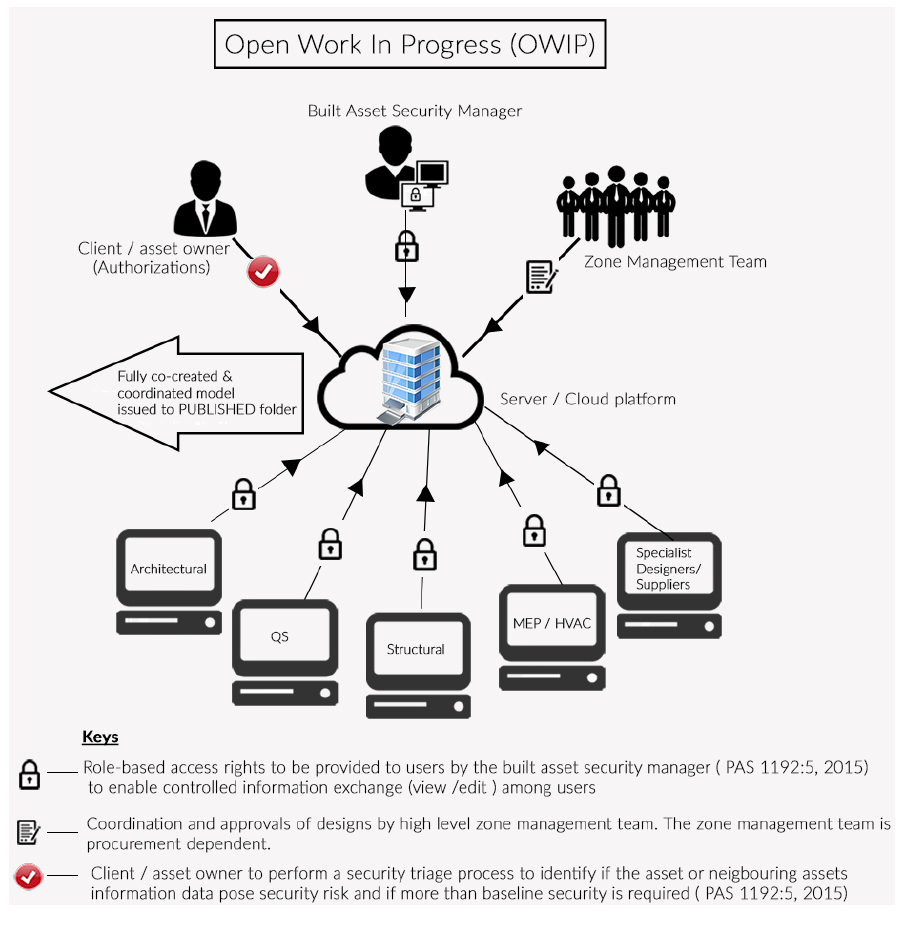
Figure 7. Information exchange and access control in OWIP.